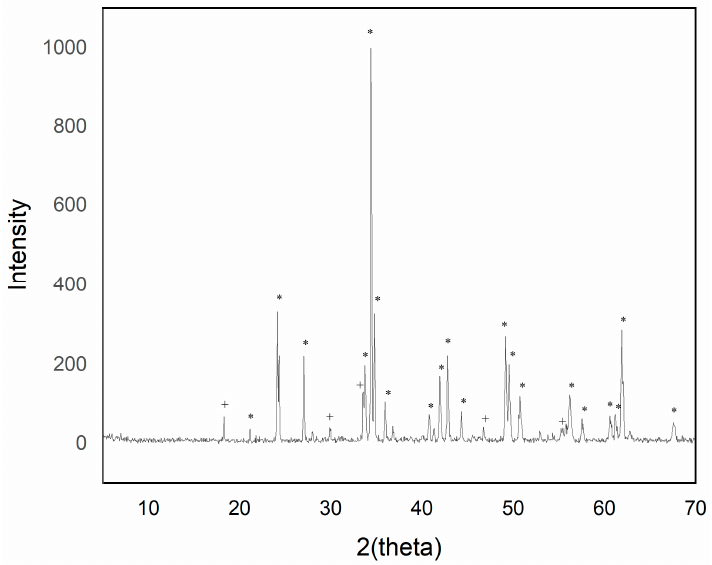
Figure 18. XRD pattern of pigment Y 0.98 Al 0.98 Cr 0.04 O 3 with flux agent mixture fired at 1400 °C/6 h (+ garnet Y 3 Al 5 O 12 phase; * perovskite YAlO 3 phase).